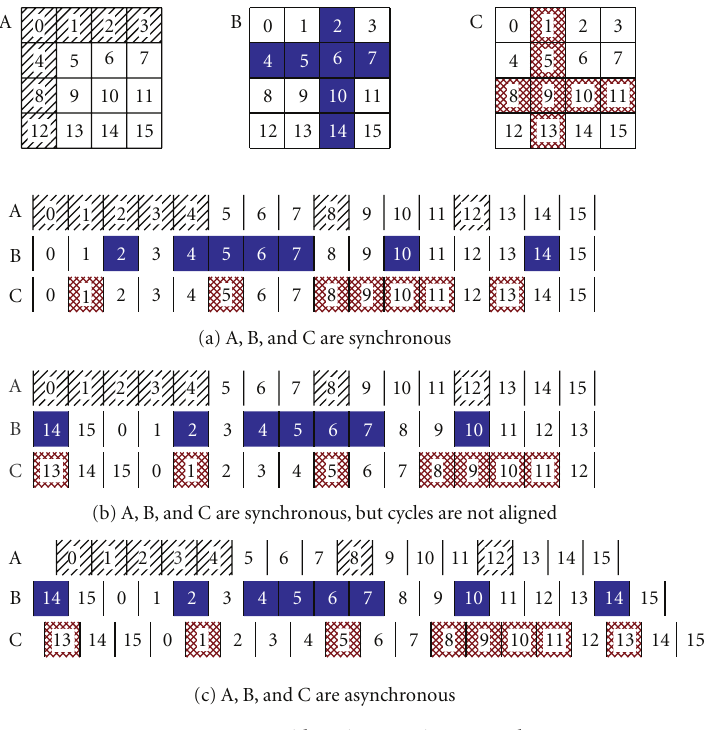
Figure 3: Grid QS intersection